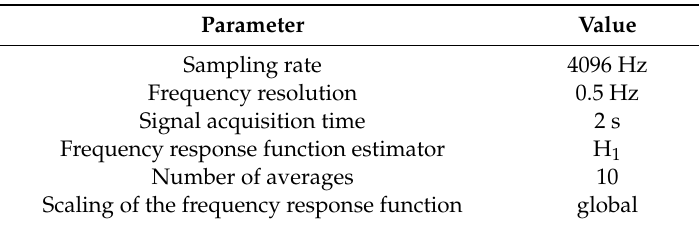
Figure 3. The test stand for the dynamic properties of the steel–polymer concrete beam ( a ) test stand; ( b ) measurement points arrangement. Table 2. Parameters of signal acquisition.